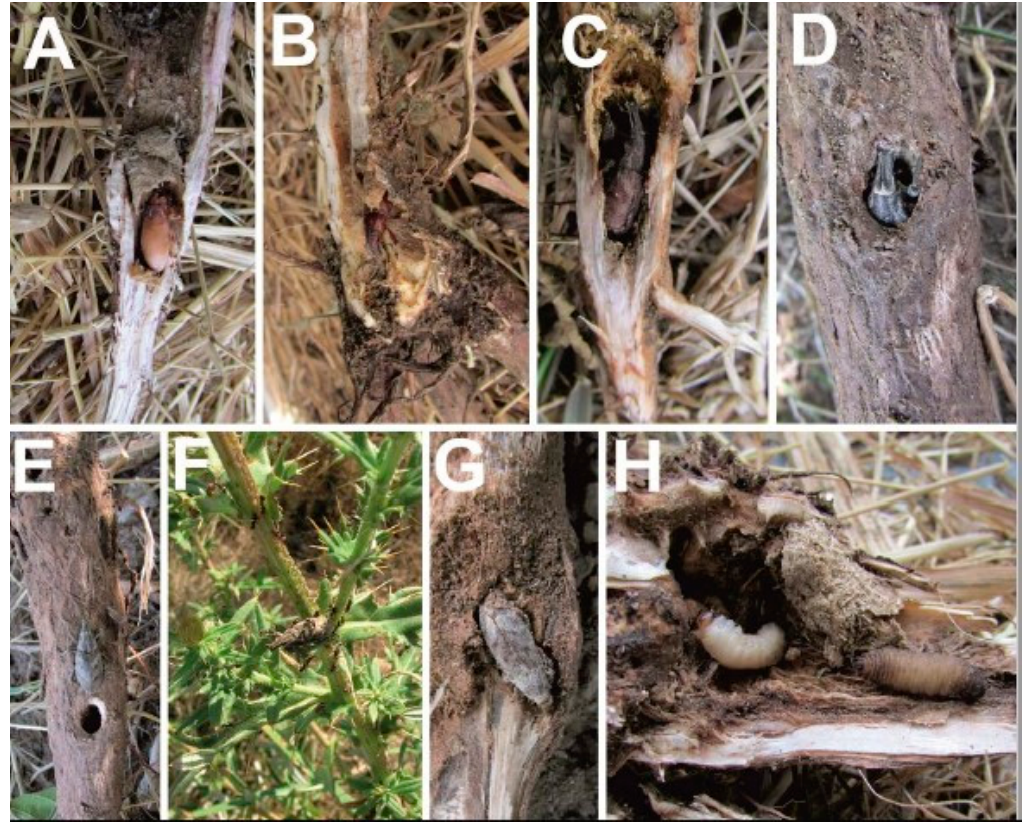
Figure 7. Cleonis pigra life history and biotic interactions. ( A )—The newly emerged adult has light-colored, soft integuments; ( B )—later, integuments become more solid and reddish-brown; ( C )—finally, the adult takes on its normal grey color; ( D )—the emergence of the adult from the stem of Cirsium ukranicum. Time: 12:19; ( E )—the emergence of the adult from the stem of Cirsium ukranicum. Time: 12:53; ( F )—ants ( Lasius ) attack the weevil on Cirsium ukranicum ; ( G )—the body of a dead beetle infected by fungi; ( H )—the larva of C. pigra and the larva of a fly ( Cheilosya ) in a root gall on Cirsium ukranicum . All photos: S. Volovnik.